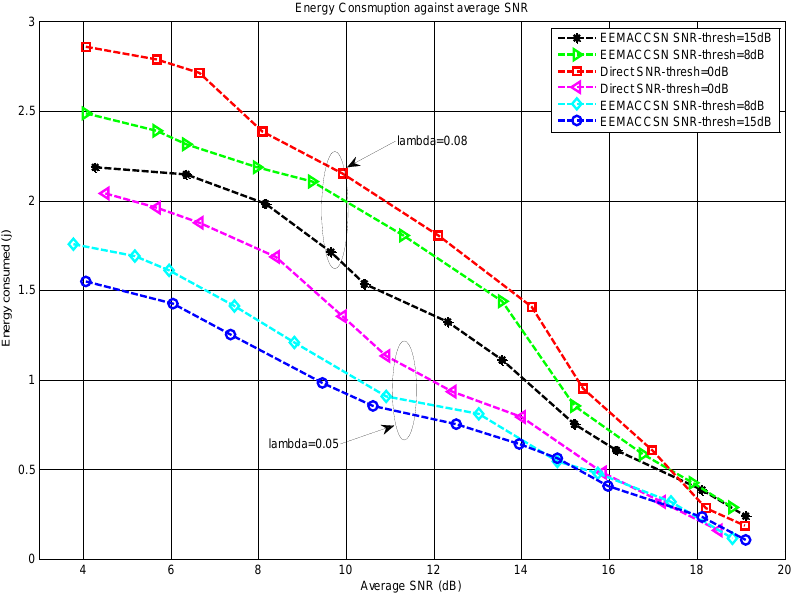
Figure 14. Energy consumption per node against average SNR.